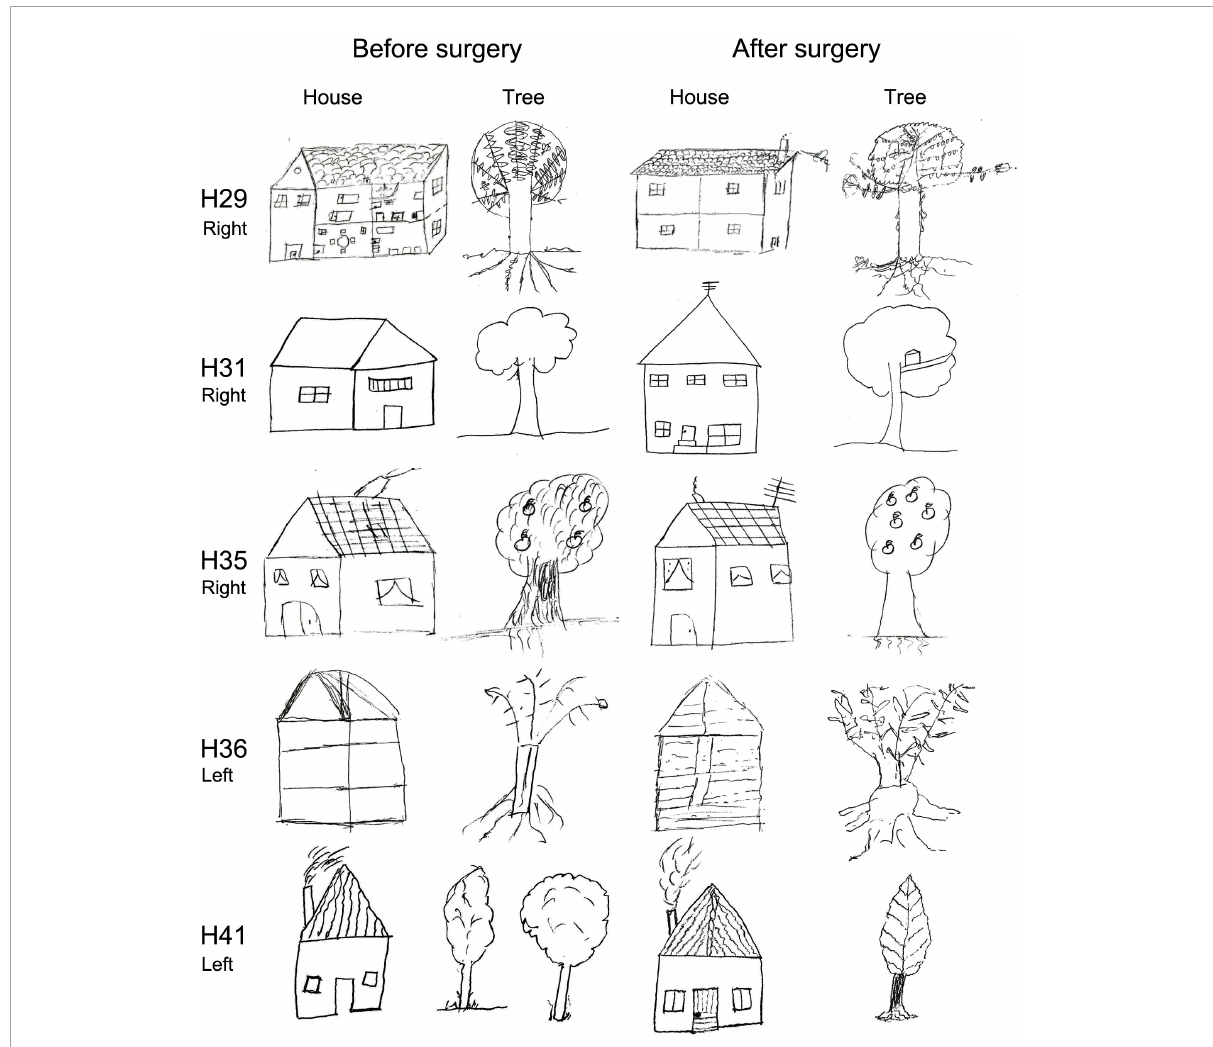
FIGURE7 House and tree drawings of the H-T-P test (before and after surgery) performed by NoHS-patients that became seizure-free after surgery. All patients were right-handed. Note transparencies (H29; house pre surgery and H29, H35, and H36 tree before and after surgery), perspective changes (H29 house after surgery) and paranoid elements (H31, H35 house after surgery). The size of the original drawings was not